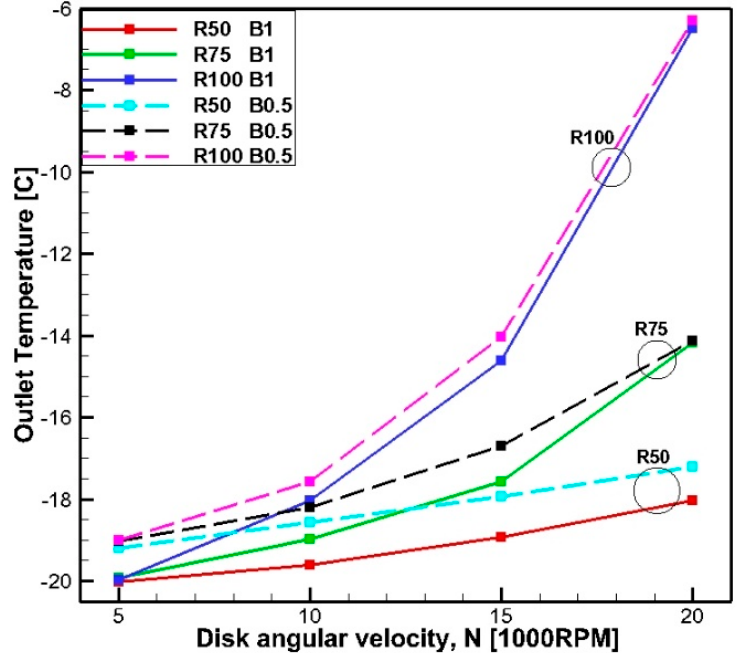
Figure 6. Variation outlet temperatures with angular velocity.